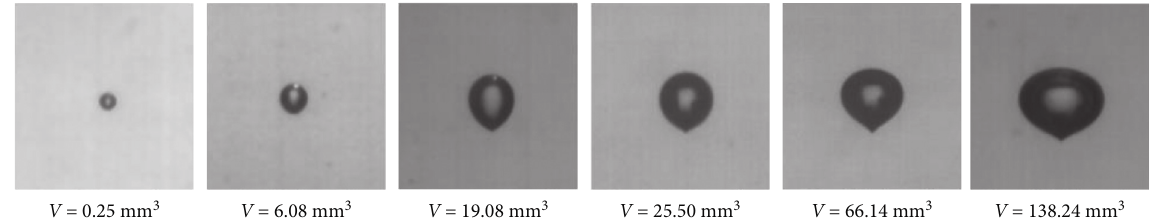
Figure 3: The bubble shape in 1.0 wt% PAAm solution (critical volume, V